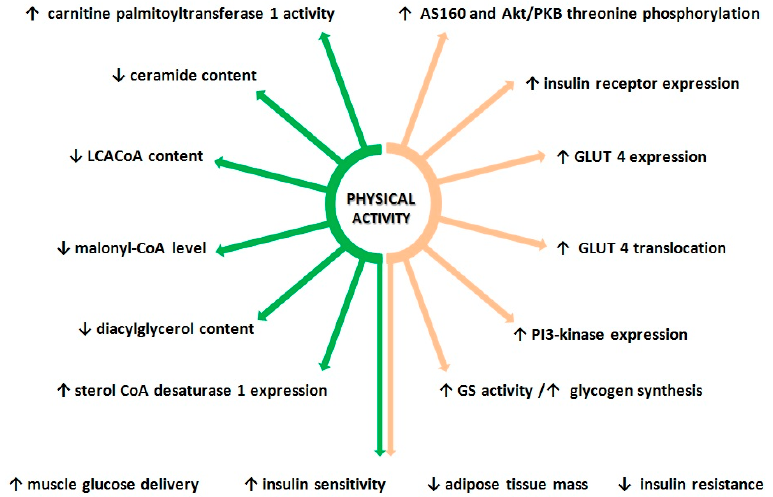
Figure 2. Effects of physical activity on lipid metabolism and insulin sensitivity. Orange arrows—impact of exercise on lipid metabolism; green arrows—impact of physical activity on glucose metabolism.